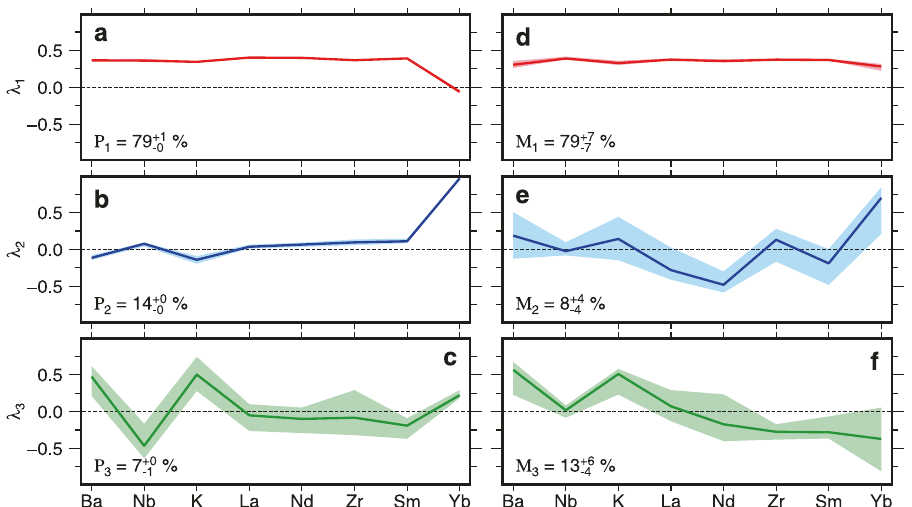
Fig. 3 Principal component analysis of incompatible element concentrations. a Average elemental weightings, λ 1 , for fi rst principal component, P 1 . Database 1 is screened and binned as described in caption of Fig. 2 before being mean-centered and variance-scaled. Colored line with shaded band = average value of λ 1 for each element with range of weighting for 99 binning con fi gurations. In this case, band is narrower than width of line. Proportion of variance described by P 1 is given in bottom left-hand corner. b Same for P 2 . c Same for P 3 . d Average elemental weightings for fi rst principal component, M 1 , generated using synthetic model that was run 99 times for appropriate range of T p , lithospheric thickness, and mantle composition. Colored line/shaded band = average value/range of λ 1 for each element. e Same for M 2 . f Same for M 3